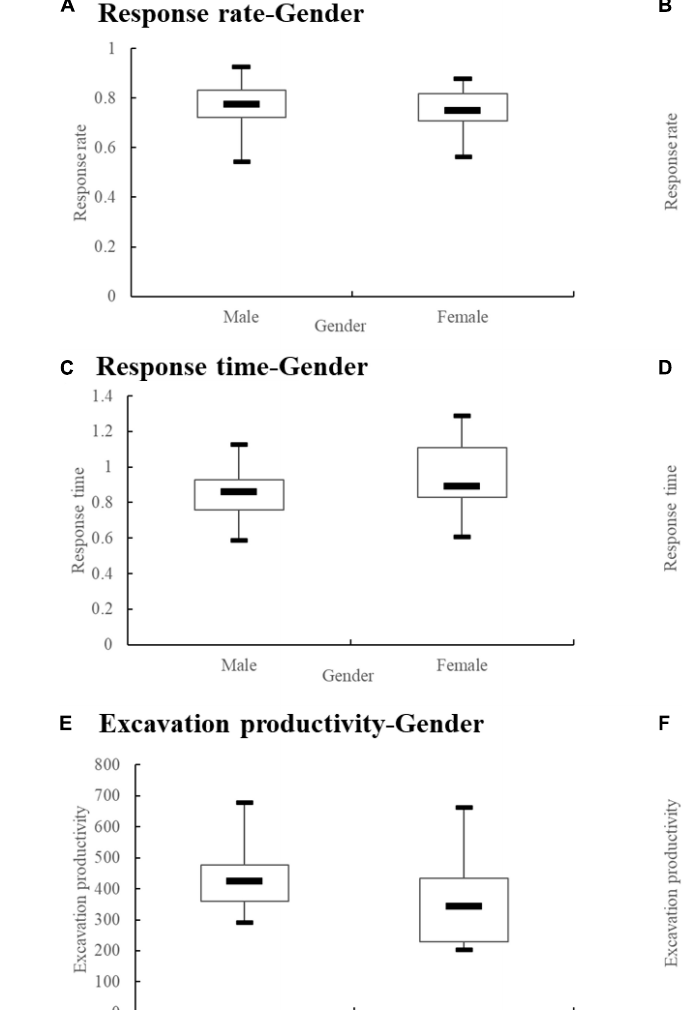
Gender demonstrates no significant effect in differentiating the performances of response rate, response time, and excavation productivity. Those who play more 3D games tended to respond quickly ( p = 0.054), but the result was not statistically significant.